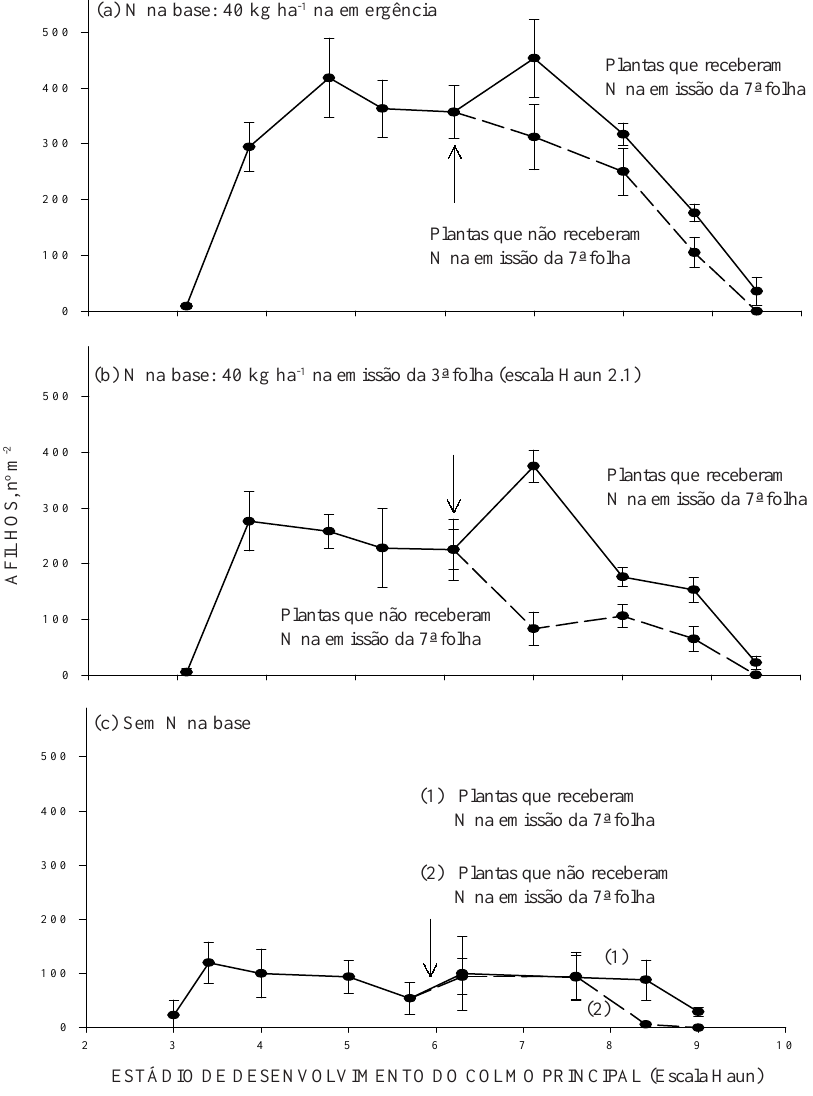
Figura 1. Evolução do número de afilhos, em 1995, em tratamentos com e sem aplicação de N no momento de emissão da 7ª folha do colmo principal (escala Haun 6.1). Barras verticais representam o desvio- padrão da média. Setas indicam o momento de aplicação de N em